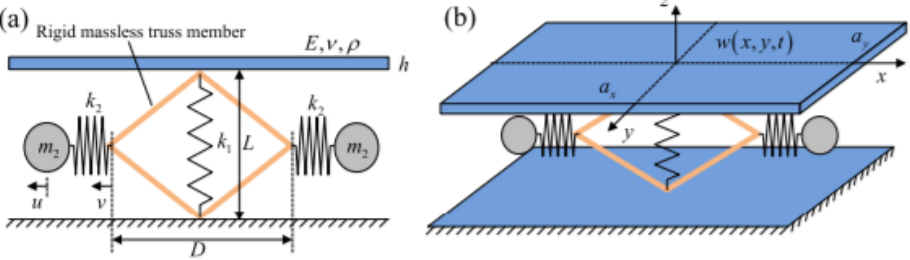
Figure 12. The unit cell of the metamaterial plate: ( a ) front view, ( b ) perspective view [48].